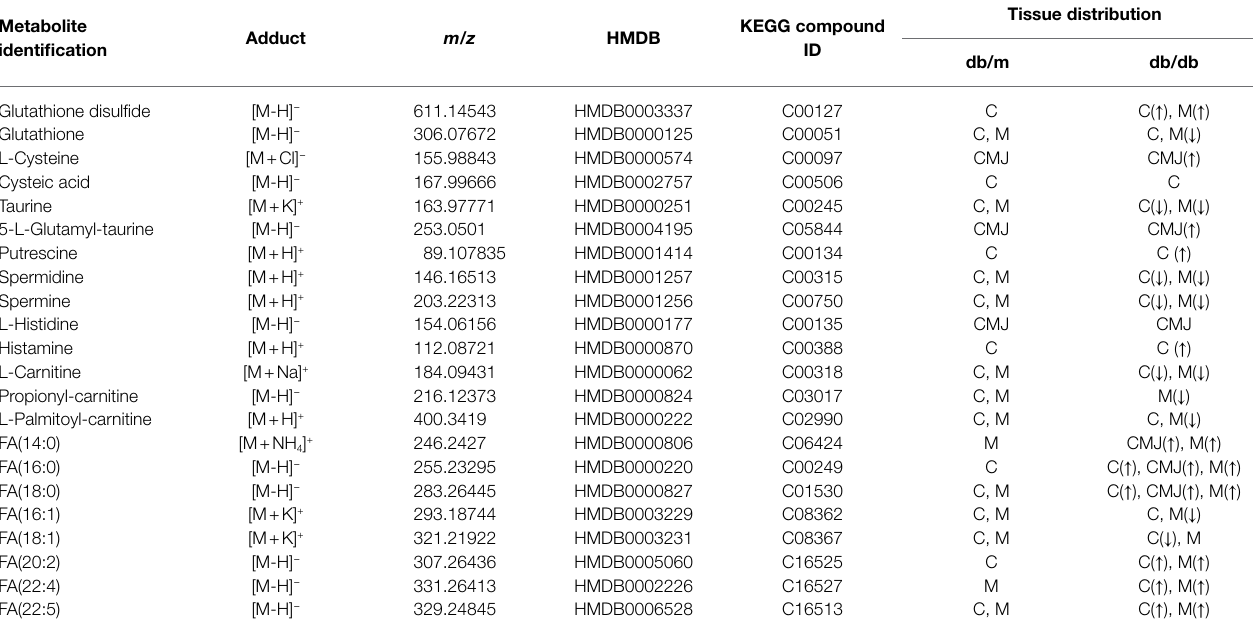
TABLE 2 | Metabolites tentatively identified in the AFADESI–MSI with renal distribution information in db/m and db/db mice. Metabolite